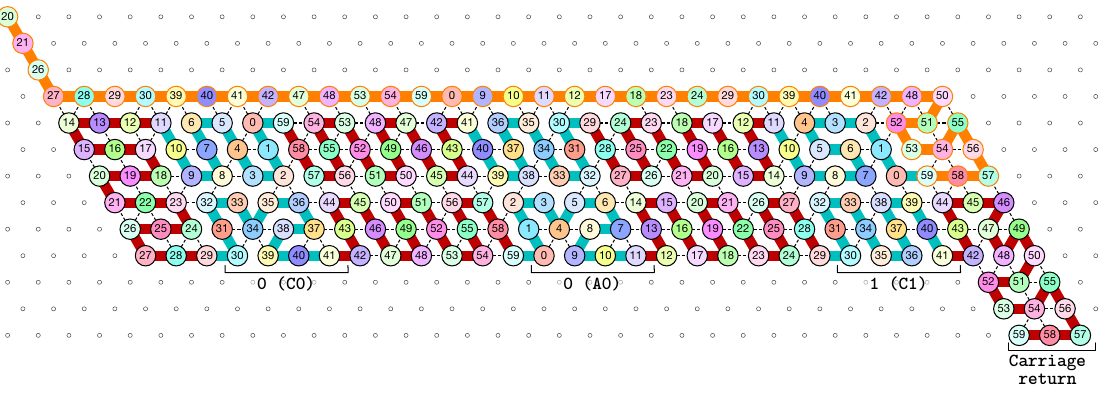
Figure 11. Finally, at the end of the first zag pass, the last module D binds to the carriage-return pattern in the seed and fold into the shape DT to accomplish the right U-turn from which the next zig pass can